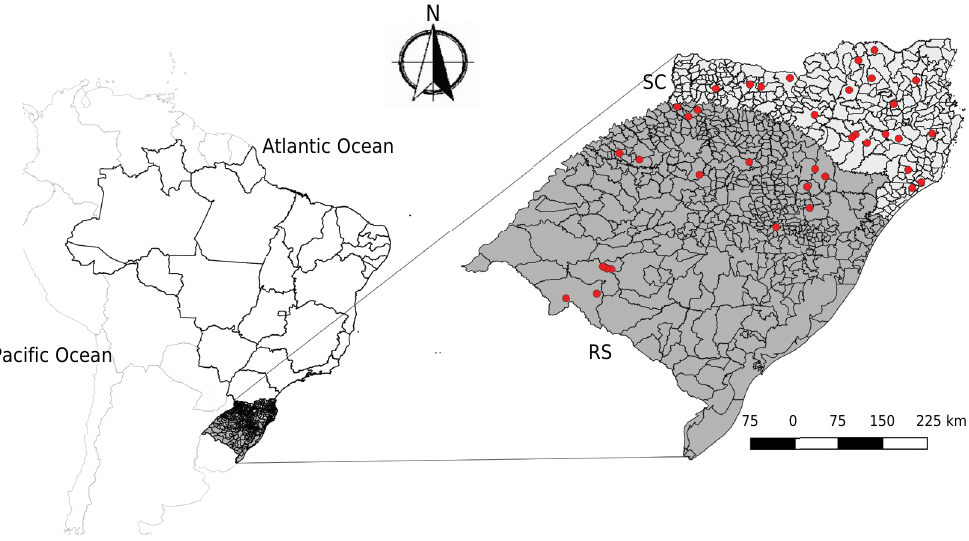
Figure 1. Spatial distribution of the 20 soil collection points in the state of Rio Grande do Sul (RS) and the 21 points sampled in the state of Santa Catarina (SC),